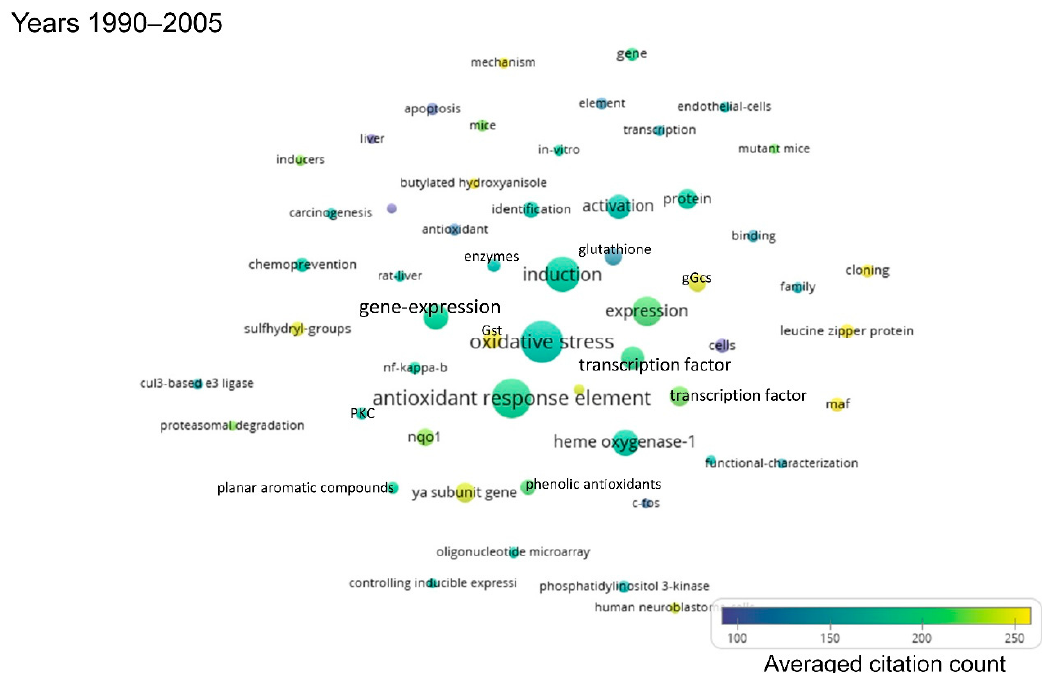
Figure 2. Term map for years 1990–2005. Bubble map showing the visualization of 55 terms that appeared in at least 10 publications published between 1990 and 2005. A bubble’s size indicates the occurrence frequency of the words (the bigger the bubble, the higher the frequency). Multiple occurrences in a single publication count as one. A bubble’s color indicates the averaged citations count received by publications containing the indicated word (i.e., the average number of citations received by the documents in which a term occurs). The proximity of two bubbles indicates the frequency of co-occurrence between the two respective words (the closer the proximity, the higher the frequency). All the terms visualized are listed in Table S1, along with their respective occurrence frequencies and averaged citations. Gst: Glutathione s-transferase, gGcs: γ -glutamylcysteine synthetase, PKC: Protein kinase C.